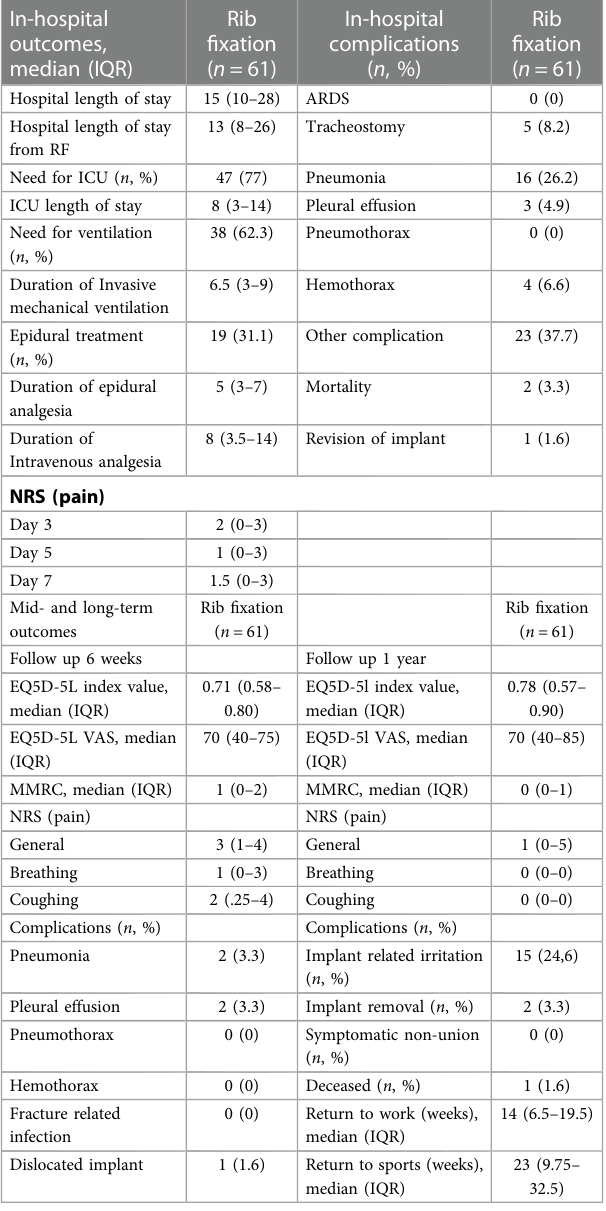
ARDS, acute respiratory distress syndrome; ICU, intensive care unit; IQR, interquartile range; MMRC, modi fi ed medical research council dyspnea scale; NRS, numeric rating scale; RF, rib fi